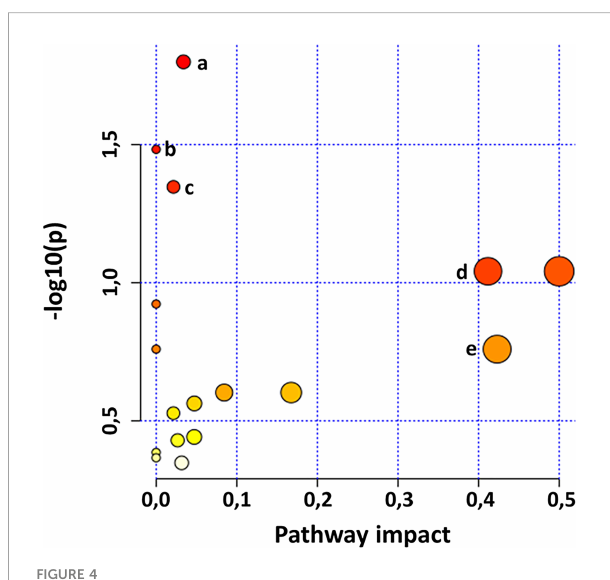
FIGURE 4 MetaboAnalyst-computed pathway analysis. View of statistically signi fi cant pathways fl agged from the metabolome view based on matched metabolites. The fi gures show pathways matched from the annotated Gariep metabolites. The pathways are arranged based on the p-value (y-axis), which indicates the pathway enrichment analysis, and pathway impact values (x-axis) representing pathway topology analysis. The node colour of each pathway is determined by the p-value (red = lowest p-value and highest statistical signi fi cance), and the node radius (size) is based on the pathway impact factor, with the biggest indicating the highest impact. Some of the most signi fi cantly impacted pathways are (A) phenylpropanoid biosynthesis, (B) aminoacyl-tRNA biosynthesis, (C) phenylalanine, tyrosine and tryptophan biosynthesis, (D) isoquinoline alkaloid biosynthesis and (E) phenylalanine